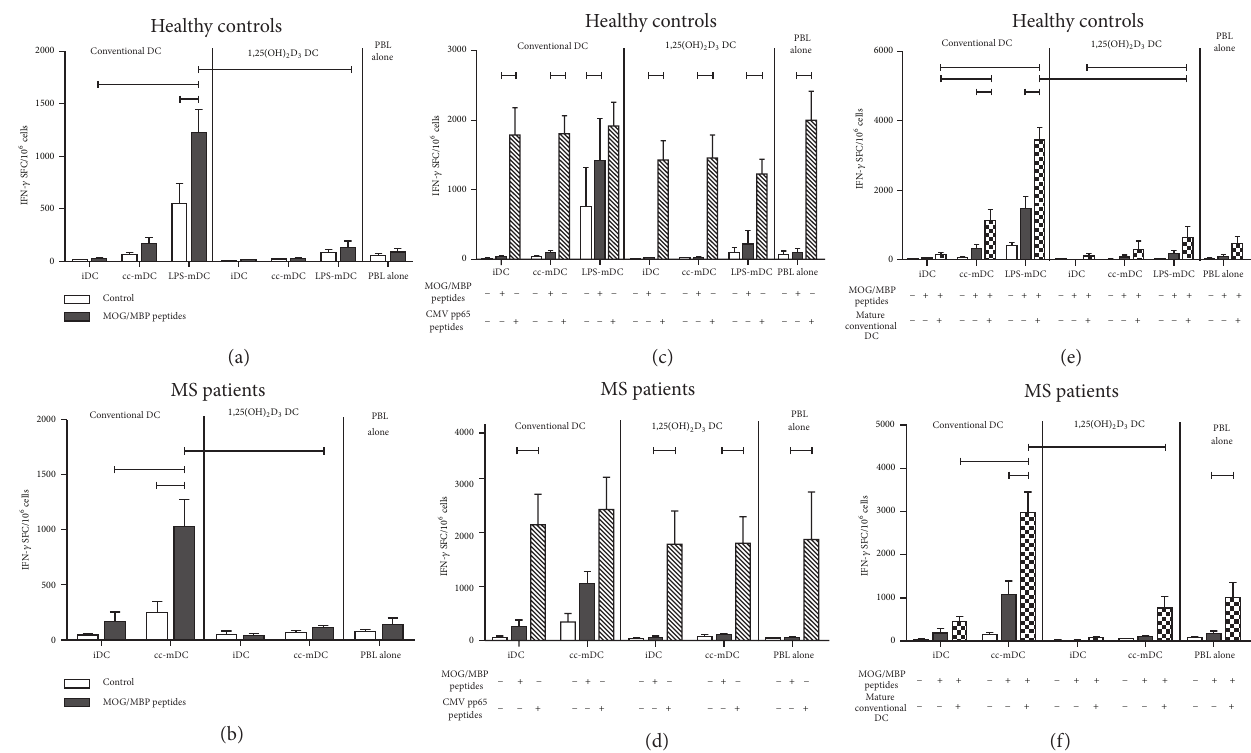
Figure 6: 1,25(OH) 2 D 3 -Treated DC induce stable antigen-specific T cell hyporesponsiveness to myelin-derived antigens (MOG/MBP peptides) in both healthy controls and MS patients. PBL stimulated with MOG/MBP peptides with or without autologous iDC or mDC were restimulated with MOG/MBP peptides (black bars) after 7 days of initial coculture. Controls represent nonrestimulated PBL (open bars). The secretion of IFN- 𝛾 was used as a measure for autologous T cell-stimulatory capacity. Each condition was measured in quadruple. Results are expressed as mean ± SEM. T cell hyporesponsiveness induced by 1,25(OH) 2 D 3 -treated DC of healthy controls ( 𝑛 = 7 ) and MS patients ( 𝑛 = 4 ) is shown, respectively, in (a) and (b). The antigen specificity of T cell hyporesponsiveness induced by 1,25(OH) 2 D 3 -treated DC was determined for healthy controls (c) and MS patients (d). PBL stimulated with MOG/MBP peptides with or without autologous DC were restimulated with either MOG/MBP peptides (black bars) or CMV pp65 peptides (dashed bars) after 7 days of initial coculture. ((e) and (f)) Stability of T cell hyporesponsiveness induced by 1,25(OH) 2 D 3 -treated DC of healthy individuals (e) and MS patients (f). PBL stimulated with MOG/MBP peptides with or without autologous DC were restimulated either with MOG/MBP peptides (black bars) or with MOG/MBP peptides combined with fully mature conventional DC (blocked bars) after 7 days of initial coculture. iDC, immature DC; cc-mDC, cytokine cocktail-matured DC; LPS-mDC, lipopolysaccharide-matured DC; PBL, peripheral blood lymphocytes; MOG, myelin oligodendrocyte glycoprotein; MBP, myelin basic protein; CMV, cytomegalovirus; and SFC, spot forming